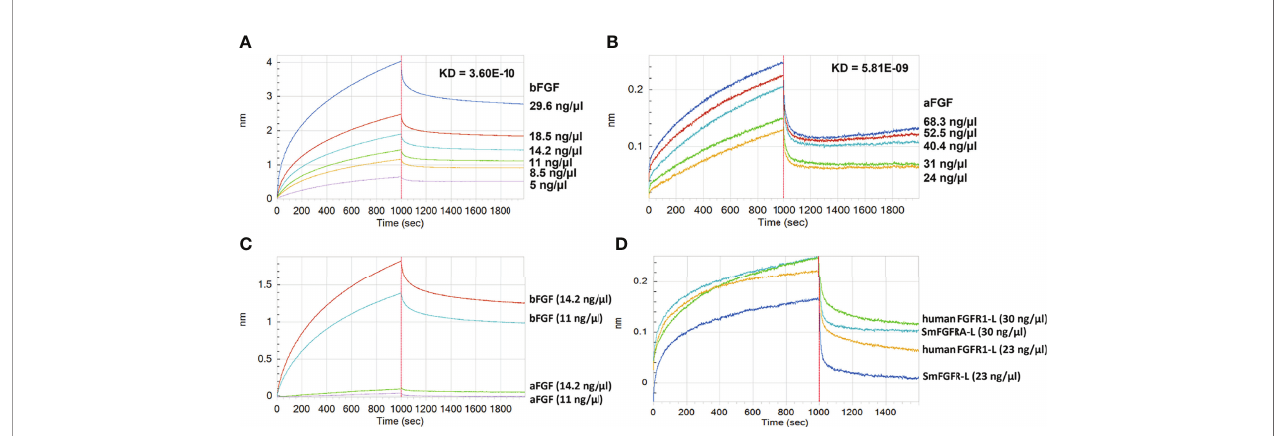
FIGURE 6 | Assays showing Binding between rSmFGFRA-L and human bFGF/aFGF using the Octet RED system. The real-time binding response between rSmFGFRA- L and (A) human bFGF and (B) human aFGF at different concentrations (ng/ m l) was monitored in seconds. The parameters of the binding af fi nity (nm) and the KD value (M) of the binding af fi nity between rSmFGFRA-L and human bFGF/aFGF are shown. (C) Comparison of the rSmFGFRA-L binding af fi nity to human bFGF and aFGF at concentrations of 14.2 ng/ m l and 11 ng/ m l, respectively. (D) Comparison of the human bFGF binding af fi nity to human FGFR1-L and rSmFGFRA-L at concentrations of 30 ng/ m l and 24 ng/ m l, respectively.